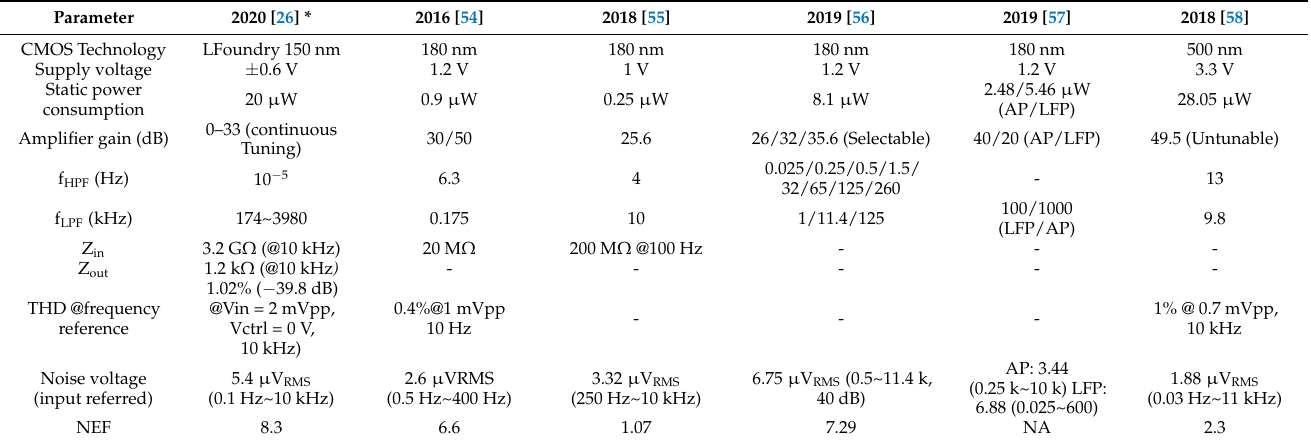
Table 5. Comparison between a VCII-based read-out circuit for biosignal conditioning and conven- tional